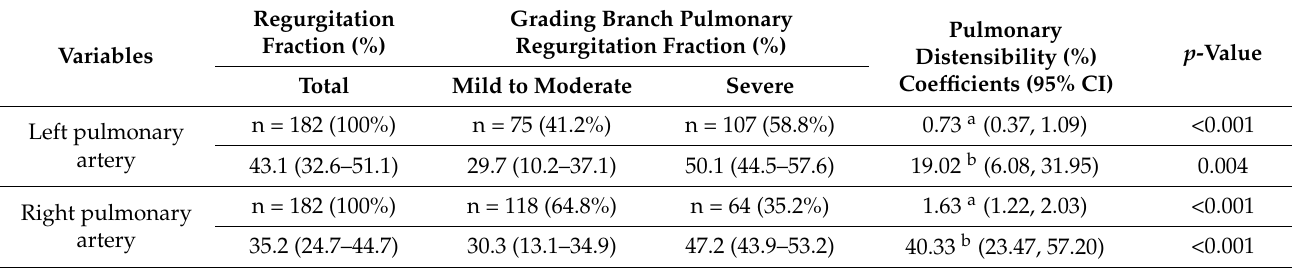
Table 4. Correlation between branch pulmonary artery regurgitation fraction and branch pulmonary distensibility.